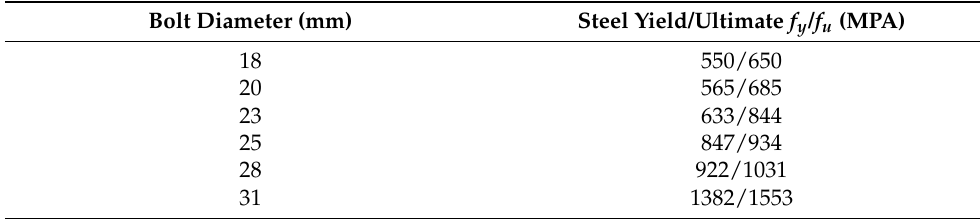
Table 10. Testing